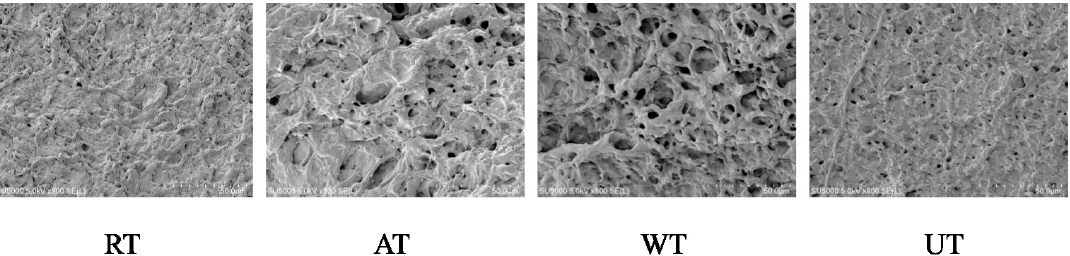
Figure 5. Influence of different thawing methods on the microstructures of frozen instant sea cucumbers (magnification: 800×).